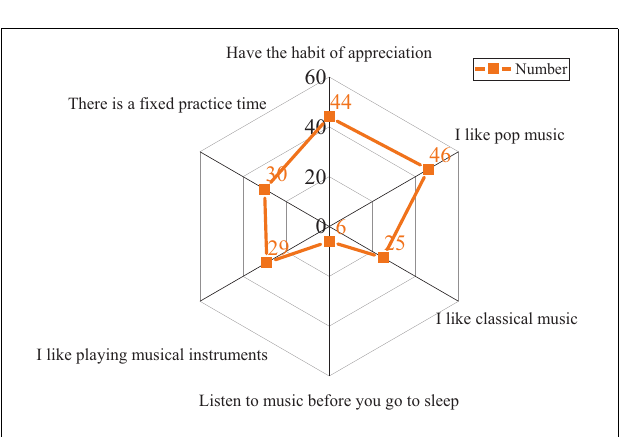
FIGURE 9 | Initiative performance analysis